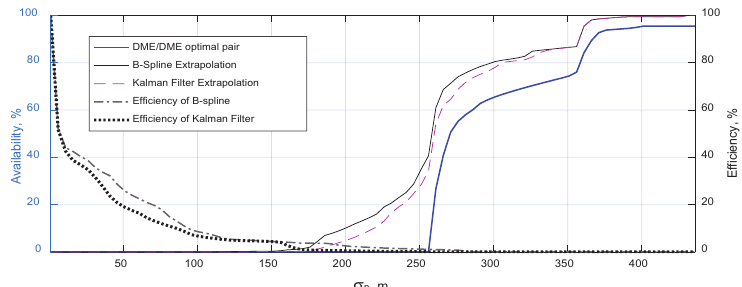
Figure 13. Availability of positioning by multiple